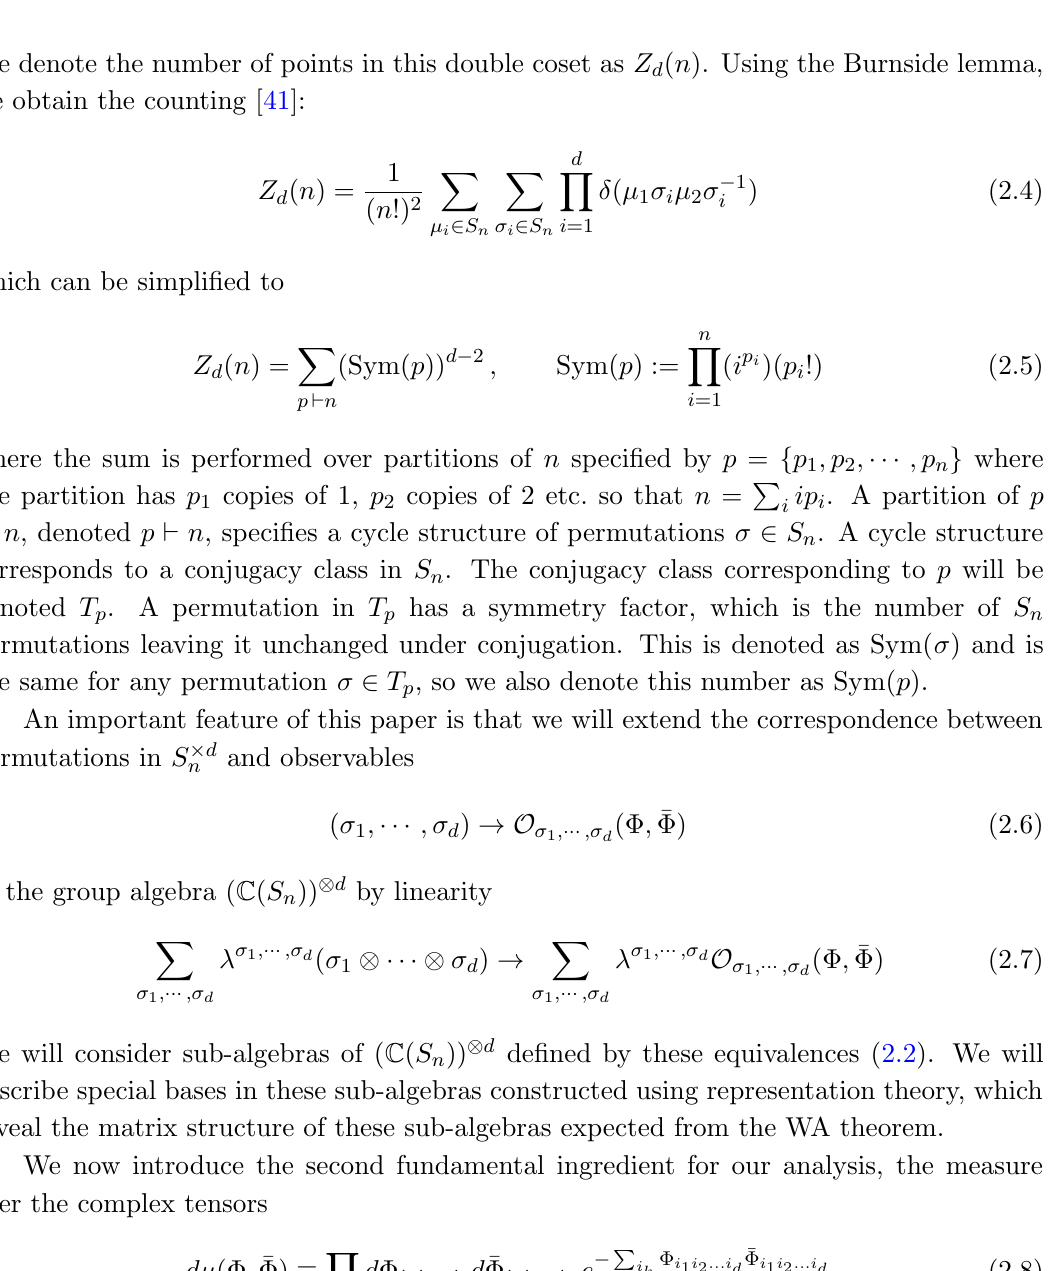
Figure 1 . Diagrammatic rank-3 tensor contraction de(cid:12)ning ( (cid:27) 1 ; (cid:27) 2 ; (cid:27) 3